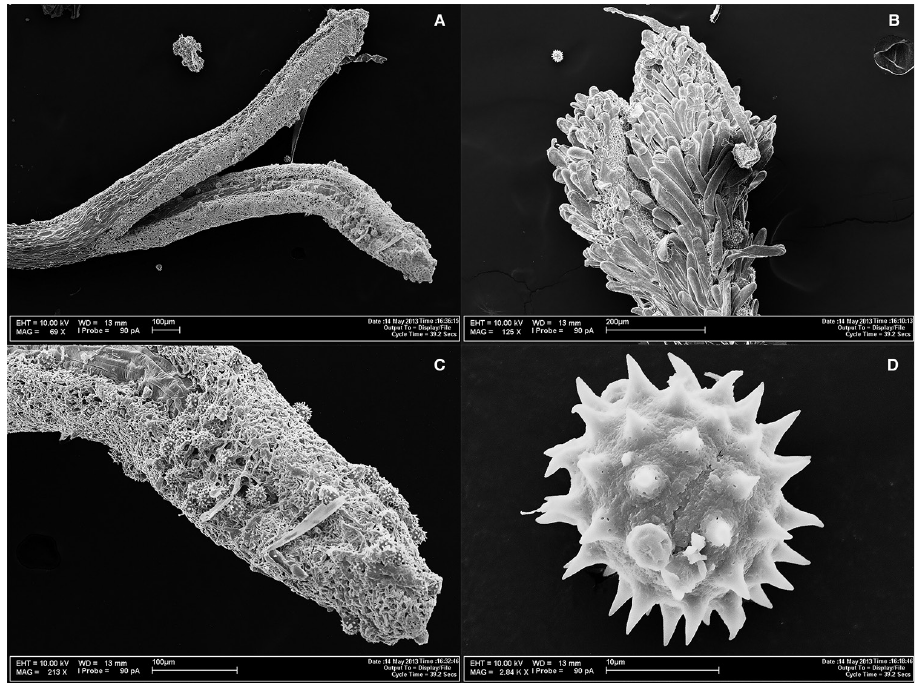
Figure 3. Photomicrographs of Espeletia praesidentis . A stigmatic branches of ray flower B stigmatic branches of disc flower with abundant papillae C detail of a stigmatic branch of ray flower with pollen grains D Pollen